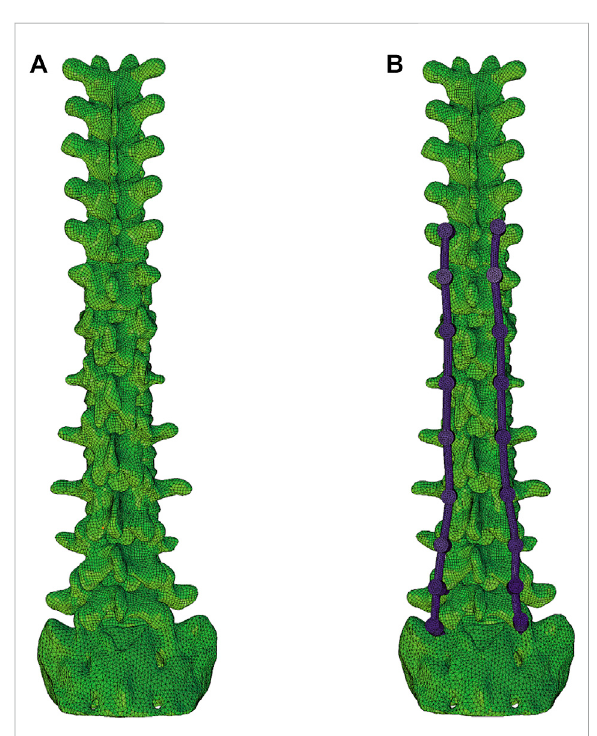
FIGURE 1 Finite element models. Model intact (A) was the native form, and model IF (B) was instrumented with a pedicle screw from segments T10 to